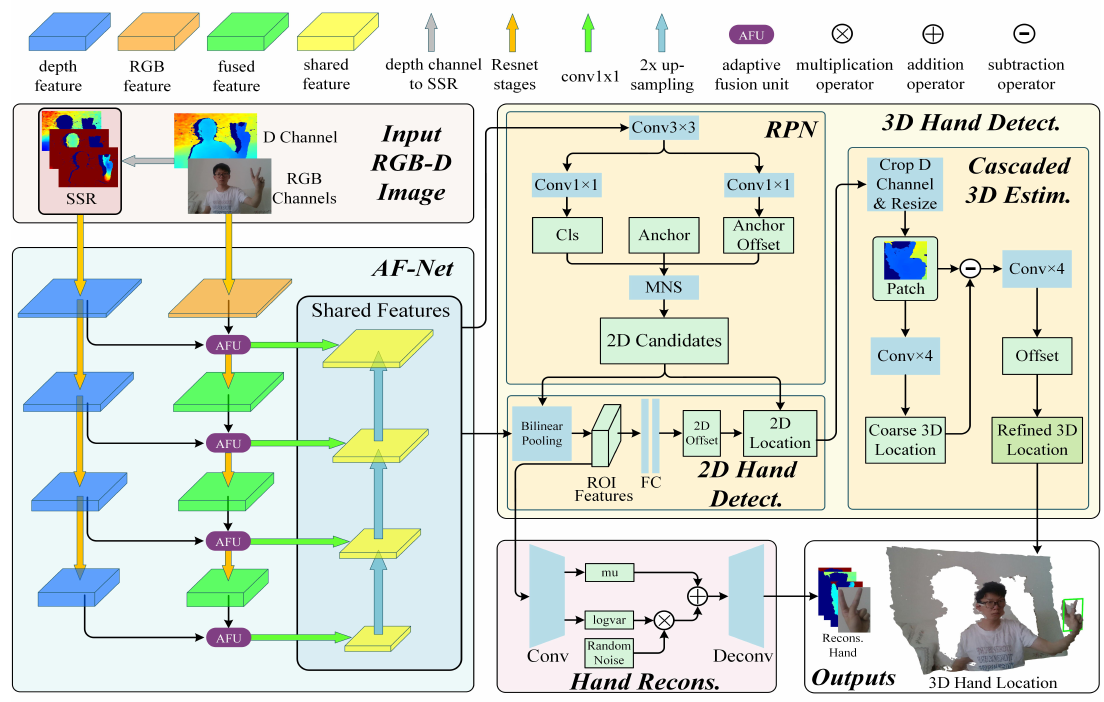
Figure 4. The framework of our 3D hand detection